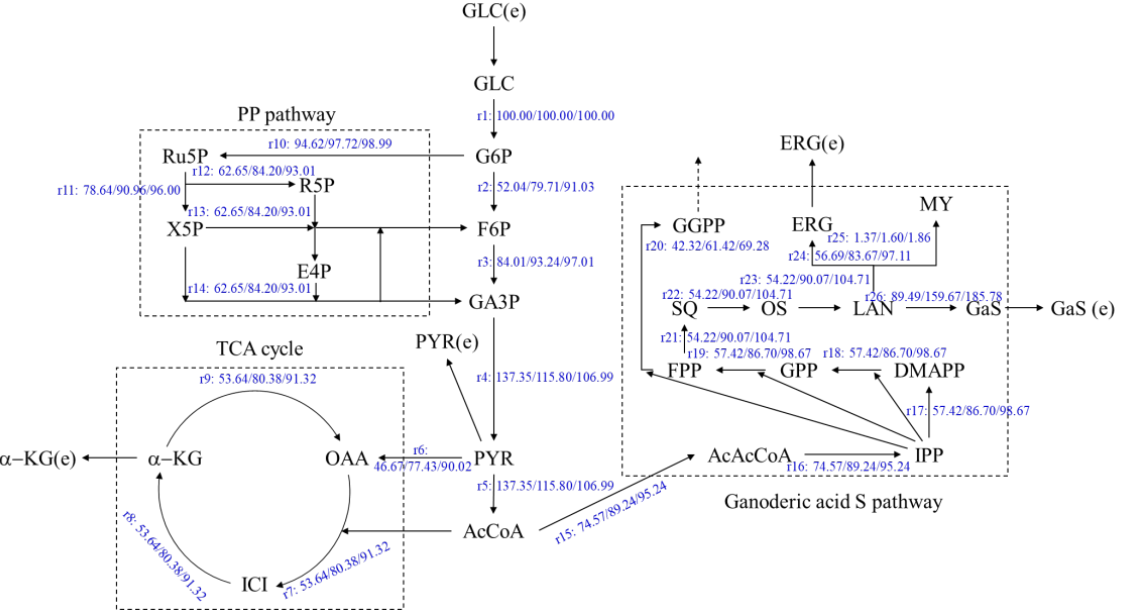
Figure 4. Metabolic flow distribution of ganoderic acid S, synthesized by submerged fermentation- static culture under two methods of oleic acid addition. Left : Control (the 10th day of static culture); Middle: Filtration-sterilization oleic acid (20 days of static culture); Right : High-temperature- sterilization oleic acid (10 days of static culture).